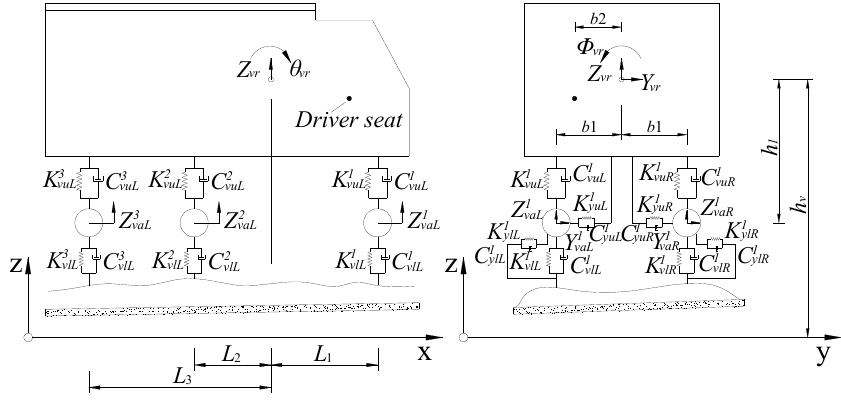
Figure 9. Dynamic model of a three-axle vehicle.